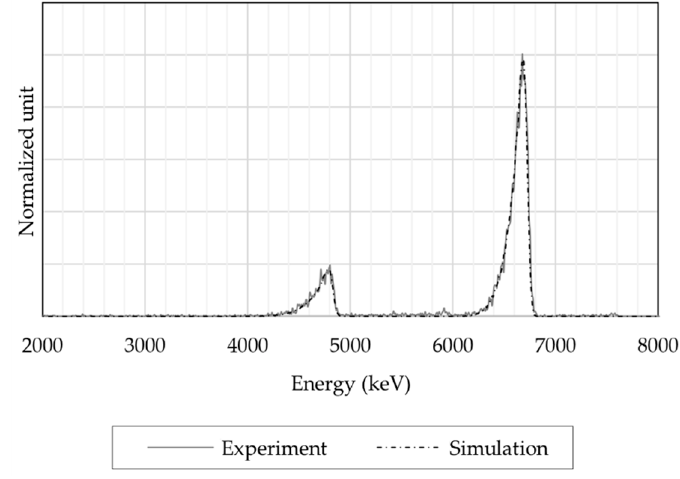
Figure 7. Comparison between an experimental spectrum and a simulated one for the two alpha emissions of 218 Po and 214 Po. Both plots are quite undistinguishable.